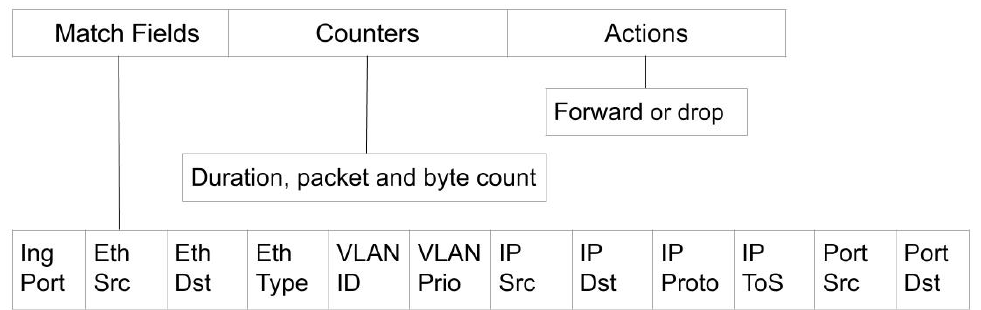
Figure 2. Flow Rule